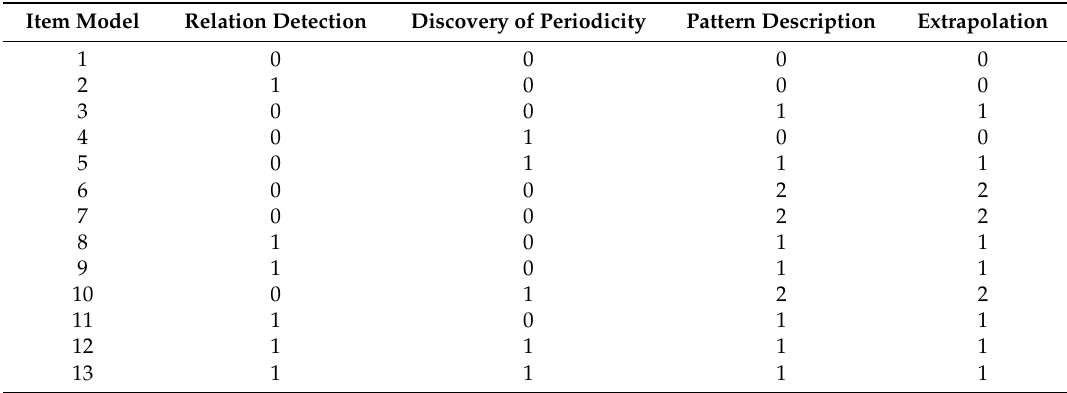
Table 5. Q-matrix of the cognitive operators proposed by Holzman et al.